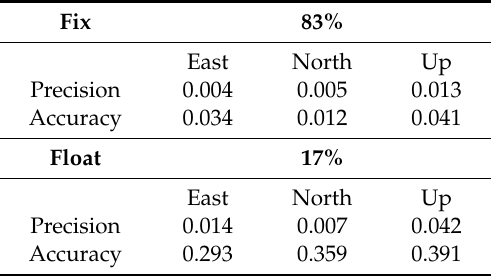
Table 12. Real-time positioning results using the u-blox receiver and a session length equal to 5 min. Values in